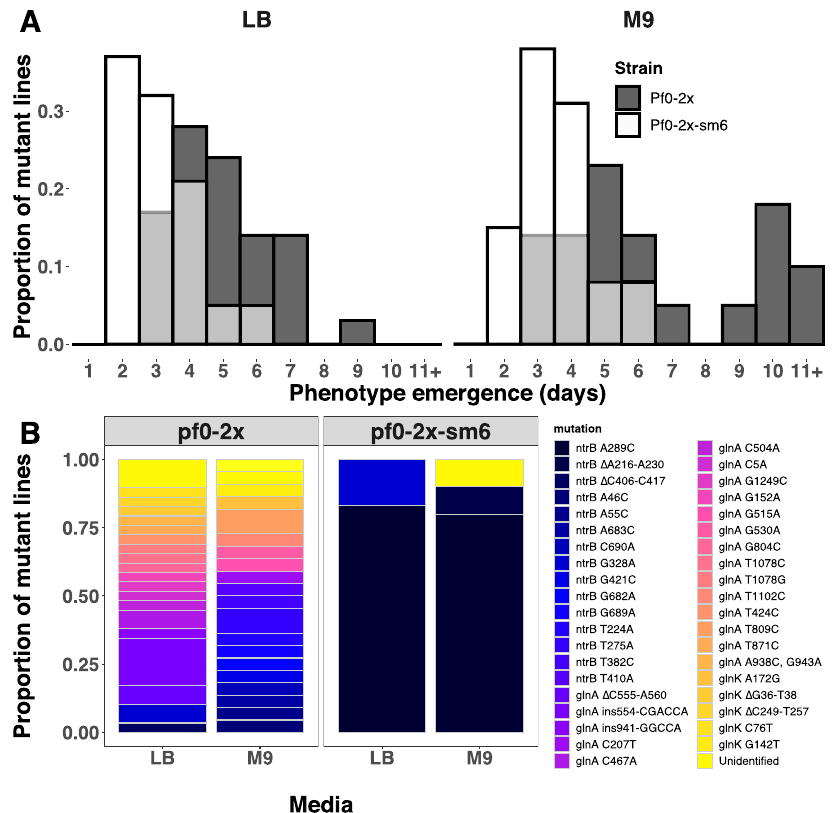
Fig. 5 A synonymous sequence mutant (Pf0-2x-sm) confers a gain of repeatable evolution. A Histogram of motility phenotype emergence times across independent replicates of an immotile variant of P. fl uorescens strain Pf0-1 (Pf0-2x 33 ,grey) and a Pf0-2x strain with six synonymous substitutions in the ntrB locus (Pf0-2x-sm6, white) in two nutrient conditions. B Observed mutational targets following directed evolution of synonymous variants, performed across two environments. Each unique mutation is highlighted by an identi fi able colour. (Sample sizes ( N ): Pf0-2x: LB N = 29, M9 N = 22; Pf0-2x-sm: LB N = 6, M9 N = 10). Unidenti fi ed mutations could not be distinguished from wild type sequences of genes belonging to the nitrogen regulatory pathway (ntrB, glnK and glnA ) which were analysed by Sanger sequencing. Mutation ntrB A289C was not observed in a single instance in evolved Pf0-2x lines but became the strongly preferred target following synonymous substitution. Source data are provided as a Source Data fi